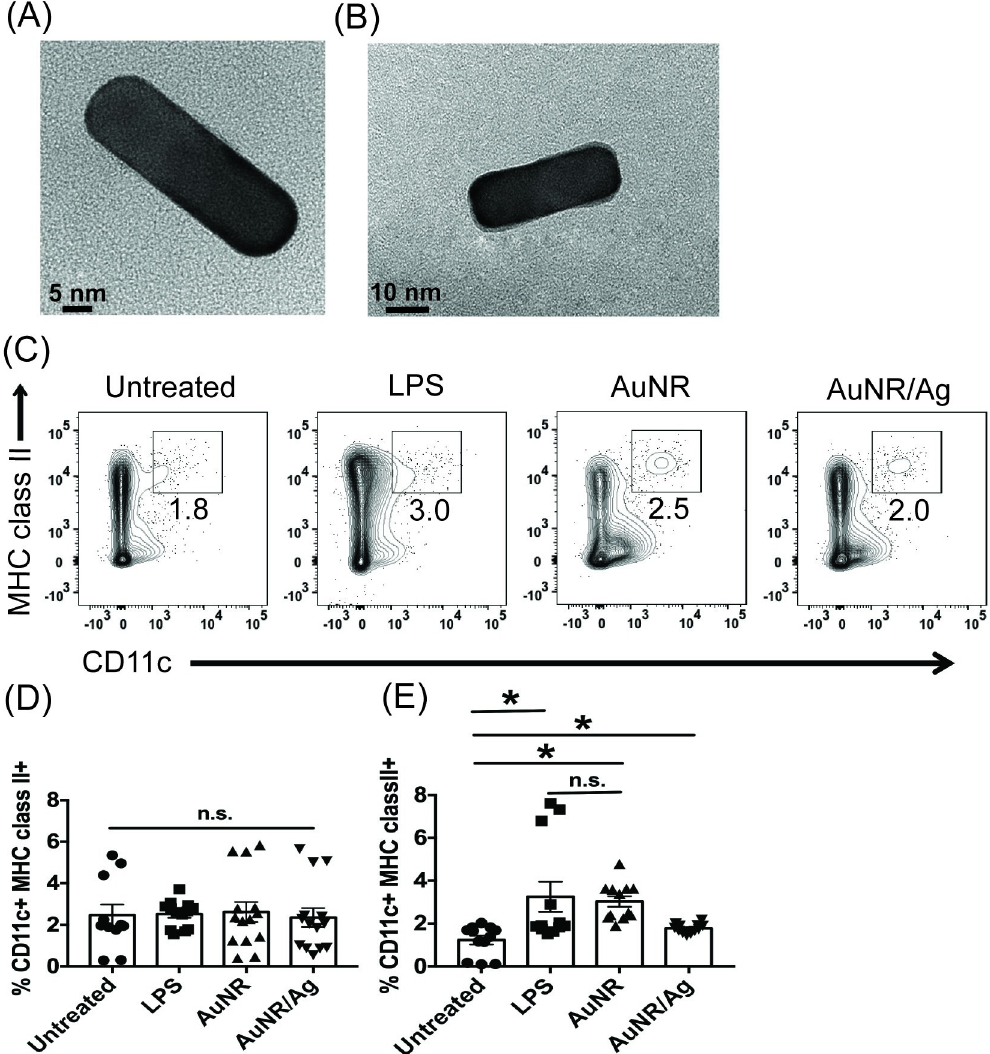
Fig 1. AuNR and AuNR/Ag’s impact on the frequencies of CD11c+ MHC classII+ DCs. TEM images of (A) AuNR and (B) AuNR/Ag. Whole splenocytes were untreated, treated with LPS (5 μ g/ml, positive control), treated with 100 μ g/ml AuNR, or treated with 100 μ g/ml AuNR/Ag for up to 72 hours. At 24 hours (D) or 72 hours (C) and (E) , cells were harvested and stained for DC markers. The flow data are gated on the percent live cells and are representative of 3 independent experiments with at least 3 technical replicates. The data is shown as scatter dot plots, where error bars represent the standard error of the mean (SEM) and � p � 0.05 is significant as determined by a two-sided t test.